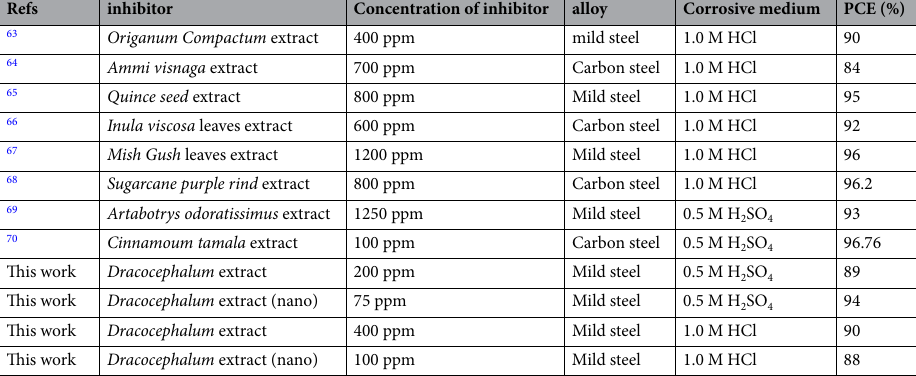
Table 6. Summary of similar studies for plant extract as a corrosion inhibitor and in comparison to this